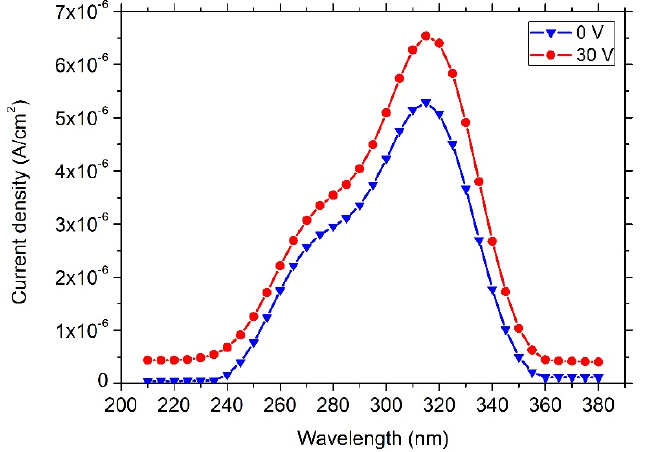
Figure 4. J–V characteristics for different UV wavelengths at RT. The incident optical power, from a monochromator, varies with the wavelength.